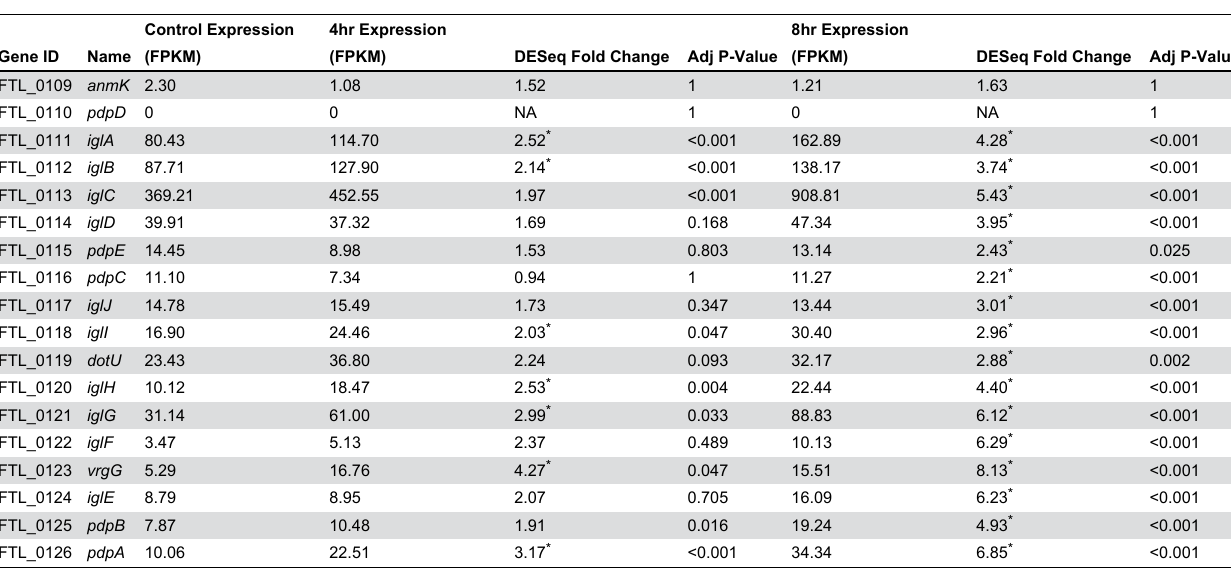
Table 3. Expression of Francisella pathogenicity island (FPI) genes